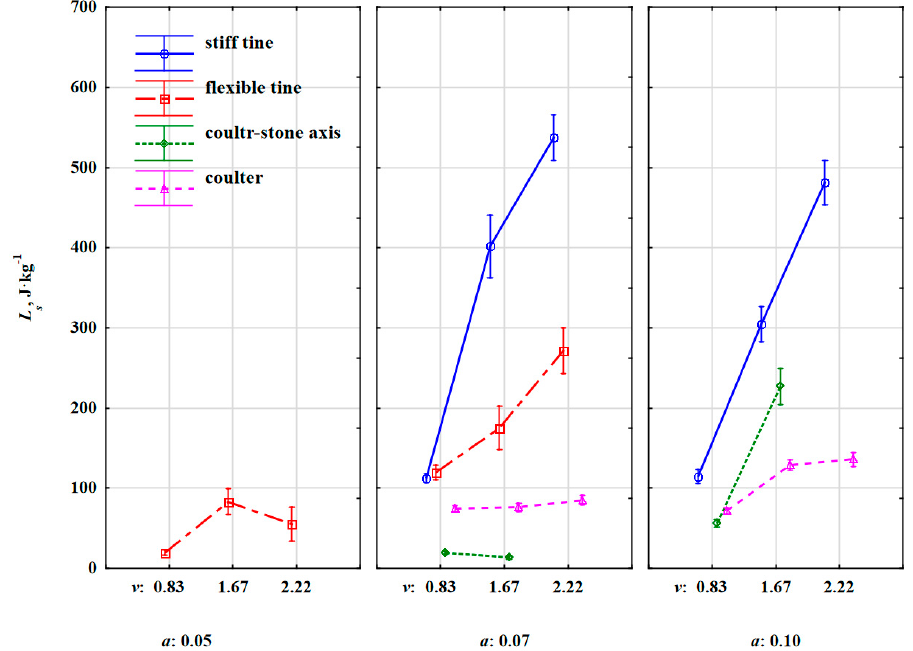
Figure 15. Specific work required to remove the stone embedded in compacted soil L s depending on the stiff tine, flexible tine, coulter-axis stones and coulter working at varied depths and working speeds.